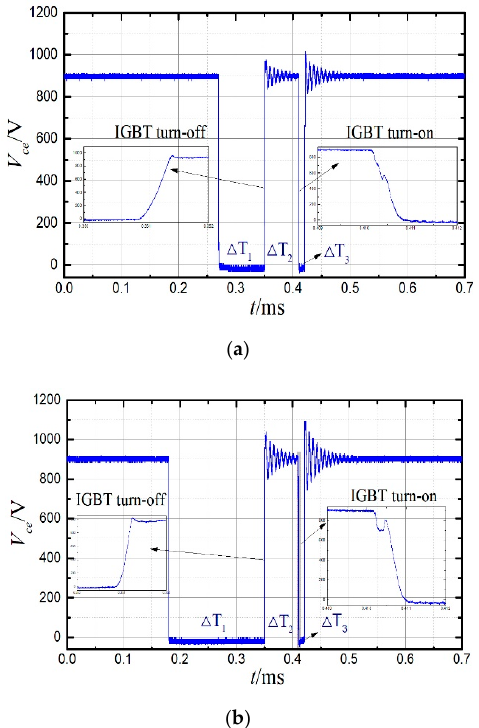
= 100 A; ( b ) I = 200 C